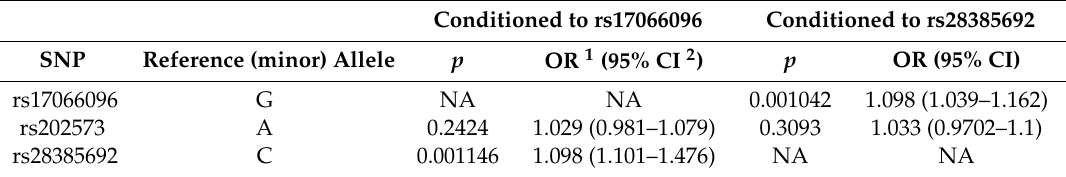
Table 3. Association values of the three SNPs in the discovery + validation datasets conditioned on